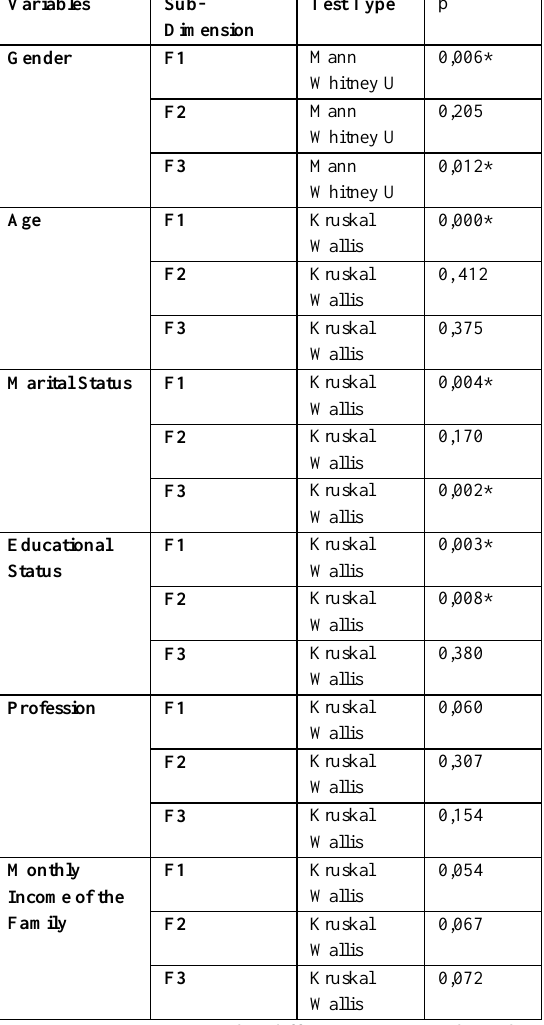
Table 6: Variations Test Results of the Sub- dimensions of the SCPGMM according to Consumer Demographics (Variables)